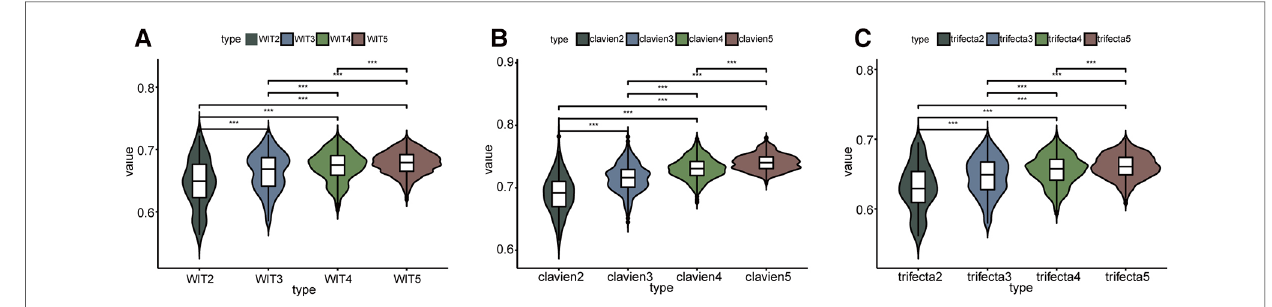
FIGURE 2 Comparison between the predictive ability of the number of different elements. WIT2 represents two elements combination to predict warm ischemia time of more than 20 min, WIT3 represents three elements combination to predict, and so on. clavien2 represents two elements combination to predict